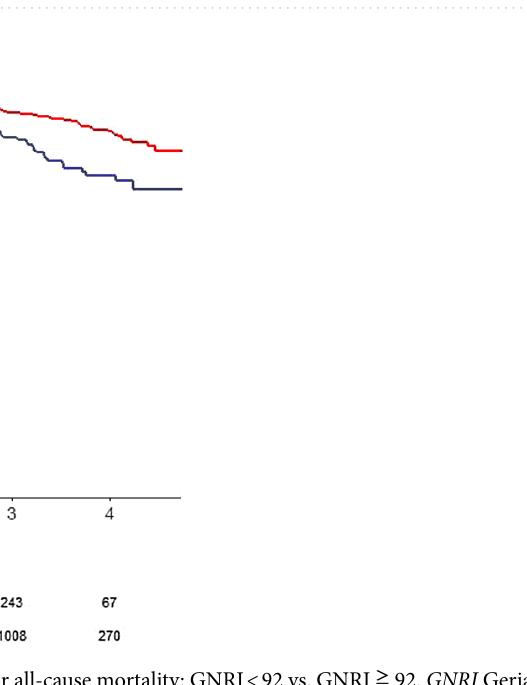
Table 2. Baseline characteristics of the incident HD patients by GNRI trend. Data are number (percentage) and mean ± standard deviation. HD hemodialysis, SBP systolic blood pressure, DBP diastolic blood pressure, ESRD end-stage renal disease, GI gastrointestinal, GNRI geriatric nutrition risk index.